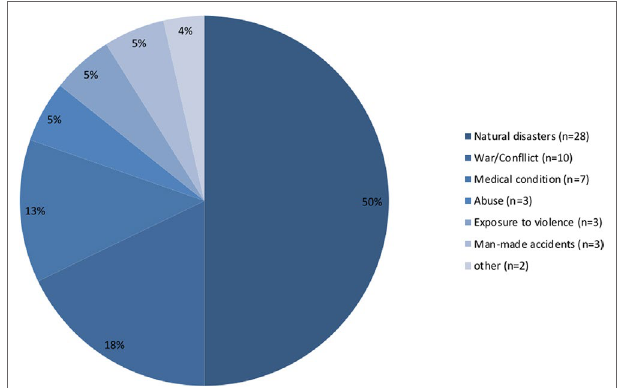
FIGURE 3 | Proportion of traumatic experiences mentioned by the studies, per trauma classification.